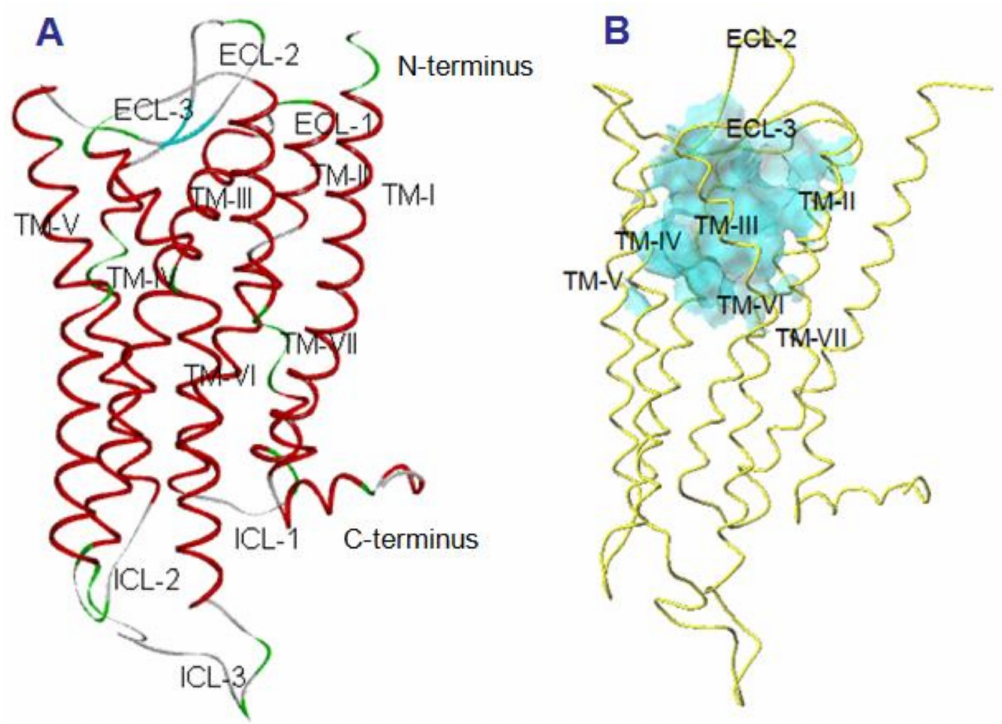
Figure 1. The 3D structure of Manse-ATR. ( A ) The seven transmembrane alpha helices (TM-I–TM-VII) are displayed in red, and are connected by the extracellular (ECL) and intracellular (ICL) loops. There is a β -strand in the ECL2 (cyan), and a α -helix in the C -terminus (red); ( B ) The probable ligand binding pocket of Manse-ATR. Side view of the binding pocket is displayed as a cyan transparent surface. There is a large hydrophobic pocket in the extracellular portion of the Manse-ATR model (consisting of TM helices and extracellular loops). This is the probable binding site of Manse-AT and the analogs used in this